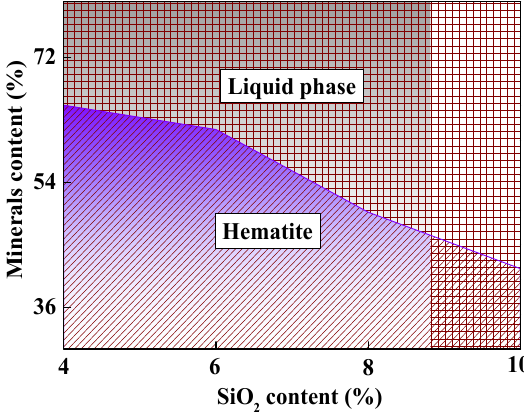
Figure 16. The minerals contents of di ff erent SiO 2 sample.